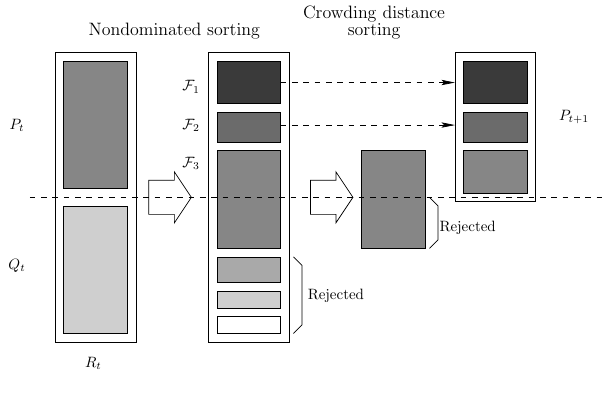
Figure 1: The crossover procedure of the NSGA II